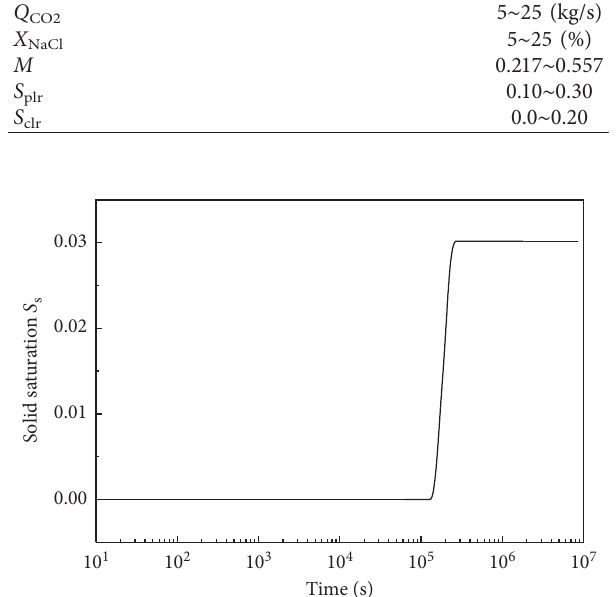
Figure 3: Time evolution of solid saturation at the observation point (injection